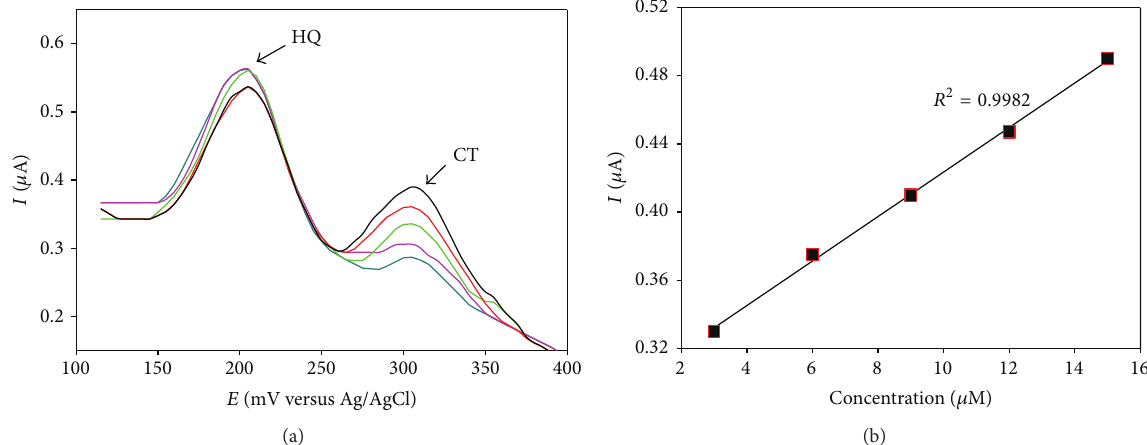
Figure 7: (a) Differential pulse voltammogram (DPV) of CT in the presence of HQ at PGA modified GCE in PBS. (b) Calibration curve for the quantitative determination of CT in the presence of HQ.